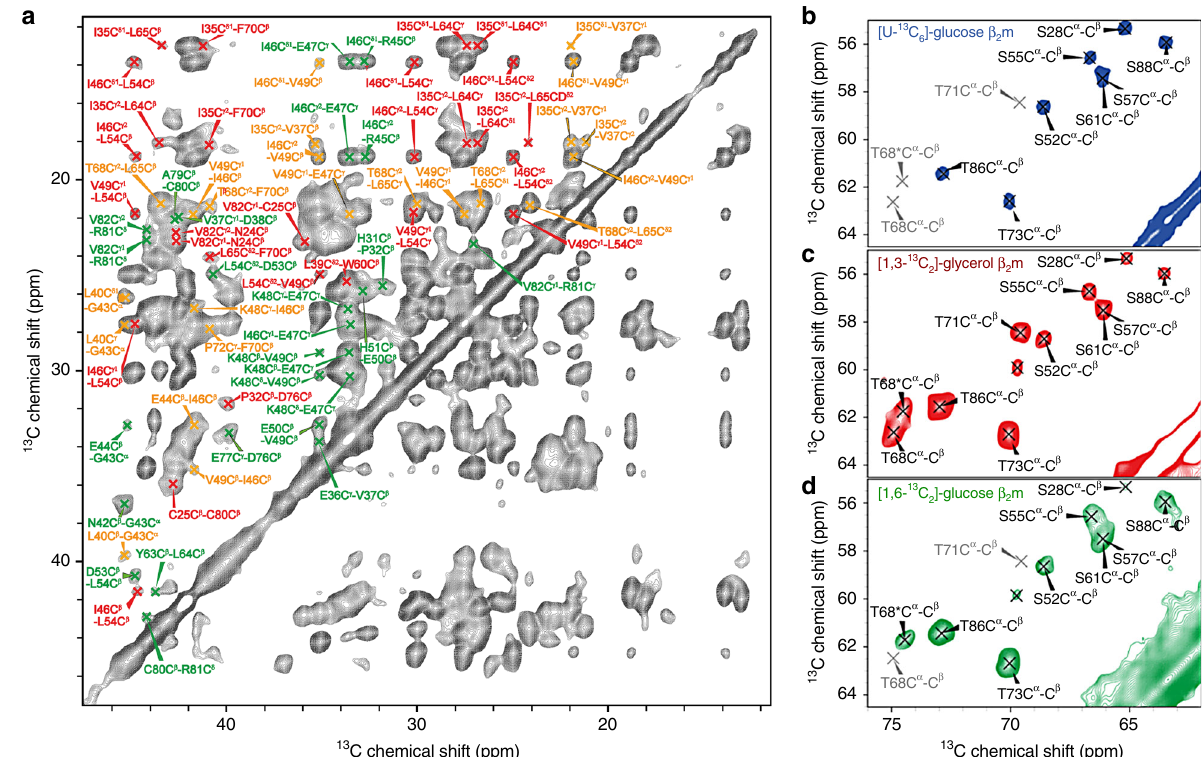
Fig. 1 MAS-NMR spectra of β 2 m fi brils show a single subunit structure. a Excerpt of a 2D 13 C – 13 C MAS spectrum of uniformly [ 13 C/ 15 N]-labelled β 2 m fi brils using 15 ms PAR mixing recorded at a fi eld strength corresponding to ω 0H /2 π = 900 MHz, T = 268 K, and ω r /2 π = 20 kHz. τ mix = 15 ms, with an 83 kHz 1 H decoupling fi eld applied during acquisition. b , c , d C α – C β correlations of Ser/Thr residues in samples differentially labelled with 13 C, as indicated for each plot. For each Ser and Thr only one correlation should be present in a monomorphic sample. Since β 2 m has 5 Thr and 9 Ser residues, a total of 14 resonances should be observed. For Ser, 6/9 expected peaks (S28, S52, S55, S57, S61, and S88) are observed. S33 is not resolved, since its C α and C β chemical shifts are identical, i.e. the cross-peak overlaps with the diagonal peak. S11 is unobserved since it is part of the region of intermediate fl exibility. We observed a weak peak that is not connected to any other residues and is believed to stem from S20. For threonine, 4 cross-peaks are expected (T68, T71, T73, T86), since T4 is part of the very fl exible N-terminus and is not observed. However, 5 cross-peaks are observed. The cross-peak of T68 exhibits doubling, presumably re fl ecting local structural perturbations for different polymorphs (see main text). Grey peak designations are included as a reference for missing peaks in this spectrum or which lie below the plotting level used. These differences are a result of the different labelling schemes and